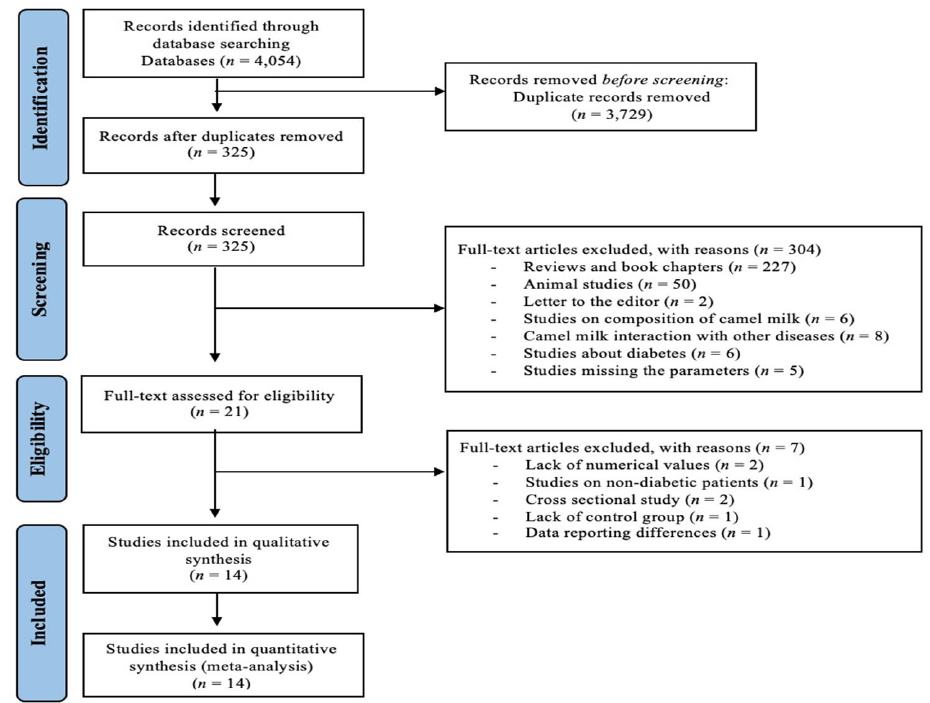
Figure 1. PRISMA flow diagram for study selection on the effect of CM on glucose homeostasis parameters.